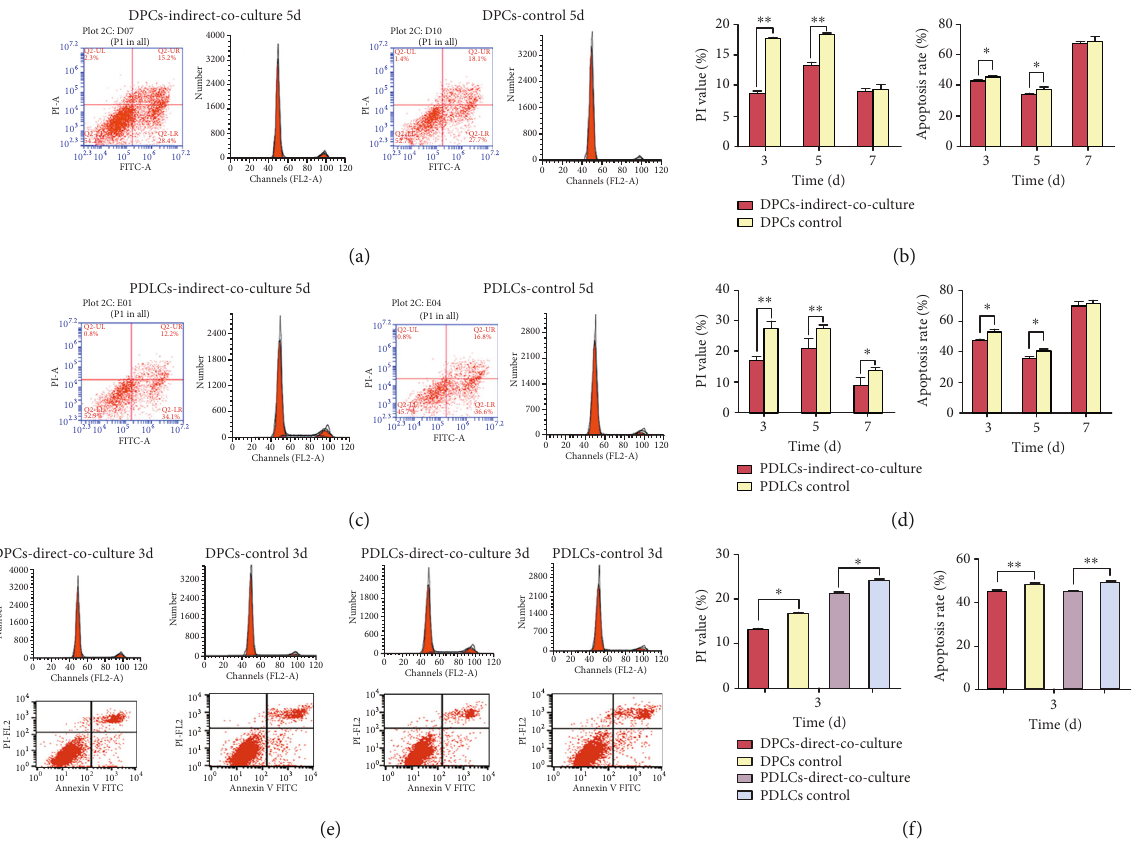
Figure 2: Cell cycle and apoptosis of DPCs and PDLCs with coculture. (a – d) The cell cycle phases of DPCs and PDLCs were arrested at the G0/G1 phase on 3 and 5 days of indirect coculture. The percentage of propidium iodinate value ð PI Þ = ð S + G2/M Þ % in cells with indirect coculture was signi fi cantly lower than those in the control groups ( ∗ P < 0 : 05 and ∗∗ P < 0 : 01 ). The apoptosis rates of DPCs and PDLCs were signi fi cantly downregulated on 3 and 5 days of indirect coculture ( ∗ P < 0 : 05 and ∗∗ P < 0 : 01 ). (a, c) Part of the results of cell cycle and apoptosis of DPCs and PDLCs performed by fl ow cytometry on 5 days of indirect coculture was represented, respectively. (e, f) The cell cycle phases and apoptosis rates of DPCs and PDLCs with 3 days of direct coculture are presented. The percentage of propidium iodinate value ð PI Þ = ð S + G2/M Þ % in cells with direct coculture was signi fi cantly lower than those in the control groups ( ∗ P < 0 : 05 and ∗∗ P < 0 : 01 ). The cell apoptosis rates of DPCs and PDLCs were signi fi cantly downregulated on 3 days of direct coculture (f, Table 3, ∗ P < 0 : 05 and ∗∗ P < 0 : 01 ). (e) Part of the results of cell cycle and apoptosis of DPCs and PDLCs performed by fl ow cytometry on days 3 of direct coculture was